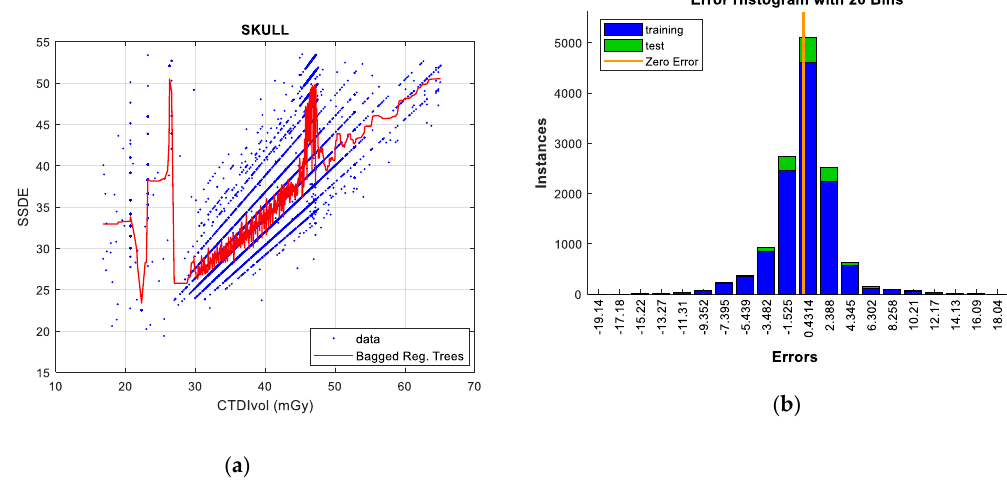
Figure 10. Size-Specific Dose Estimate (SSDE) prediction according to CTDI VOL for skull protocol ( left ), together with error histograms ( right ), employing the ‘ bagged ’ regression trees technique ( a , b ). In the Skull protocol, while considering the whole population, the bagged regression trees and GPR